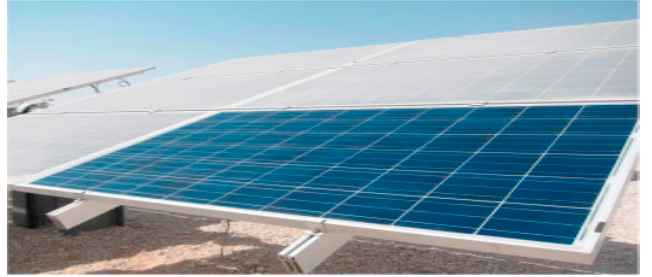
Figure 1. PV system after one month of soiling at the Qatari QEERI Solar Test Facility